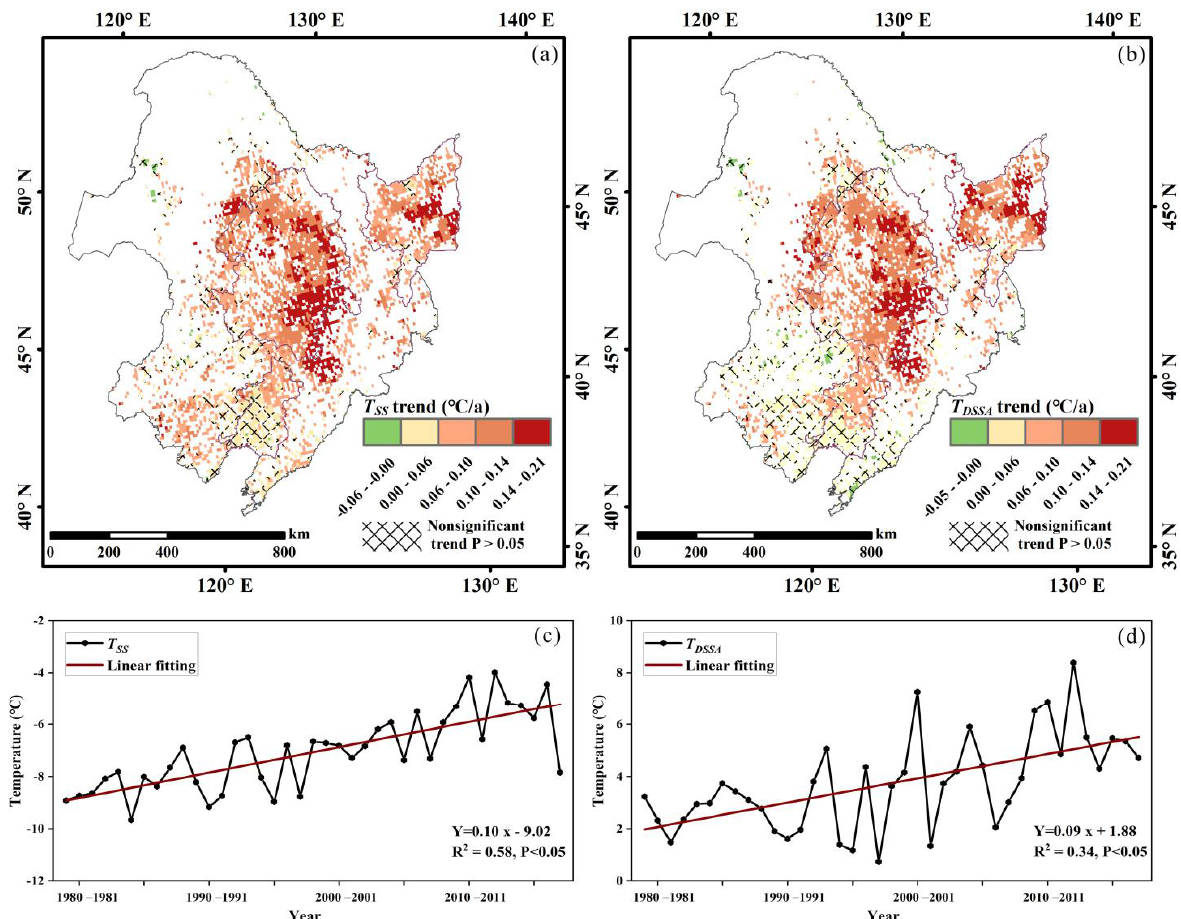
Figure 4. ( a , b ) are the linear trend of the annual average T SS and T DSSA at each grid from 1979 to 2018, respectively. ( c , d ) are the linear trend of the annual average T SS and T DSSA in all farmland in NEC from 1979 to 2018. The solid lines in ( c , d ) denote the linear regression trend over the period 1979–2018.